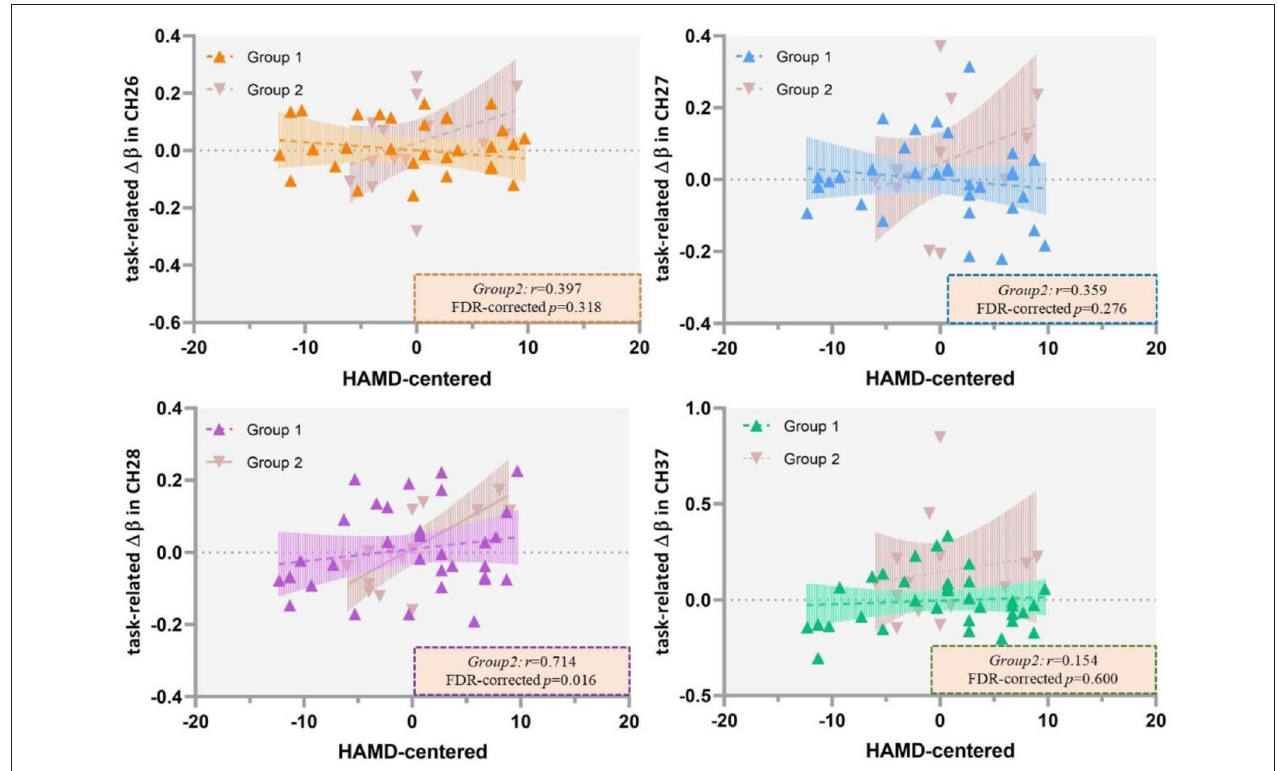
FIGURE 7 | Correlation between HAMD mean centered scores and the VFT-related 1 β ( β post − β pre ) in patients with mild to moderate depression (Group 1) and severe depression (Group 2). HAMD, Hamilton Depression Rating Scale-24; VFT, verbal fluency